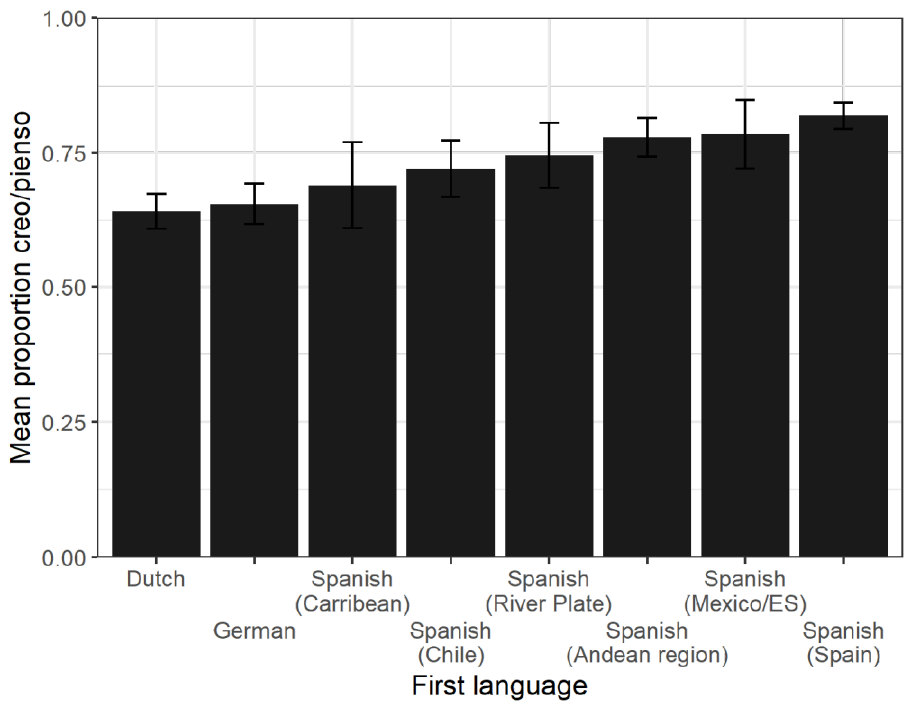
Figure 2. Mean creo que/pienso que proportions of different groups of Spanish speakers, based on their mother tongue, where pienso que = 0 and creo que =